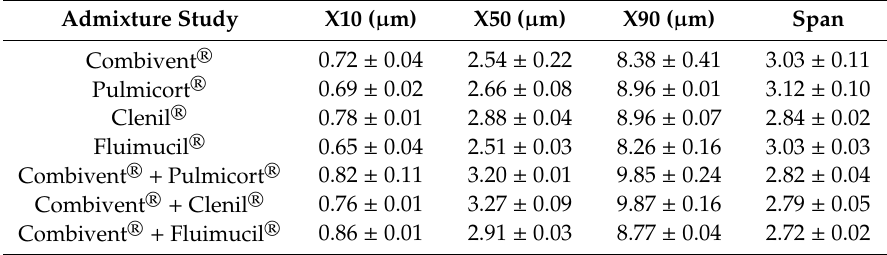
Table 7. X10, X50, X90 and span of single and mixed inhalation solutions / suspensions.